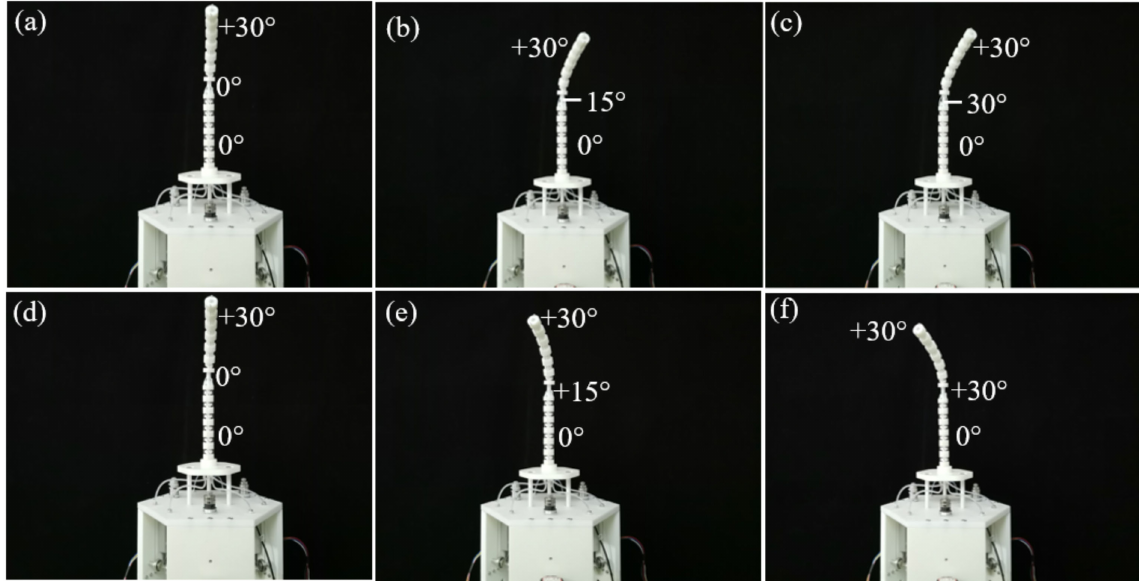
Figure 22. Bending configurations of the robot after rotating segment motion. ( a ) The initial configu- ration. ( b ) The configuration with the rotating angle of − 15 ◦ . ( c ) The configuration with the rotating angle of − 30 ◦ . ( d ) The initial configuration. ( e ) The configuration with the rotating angle of +15 ◦ . ( f ) The configuration with the rotating angle of +30 ◦